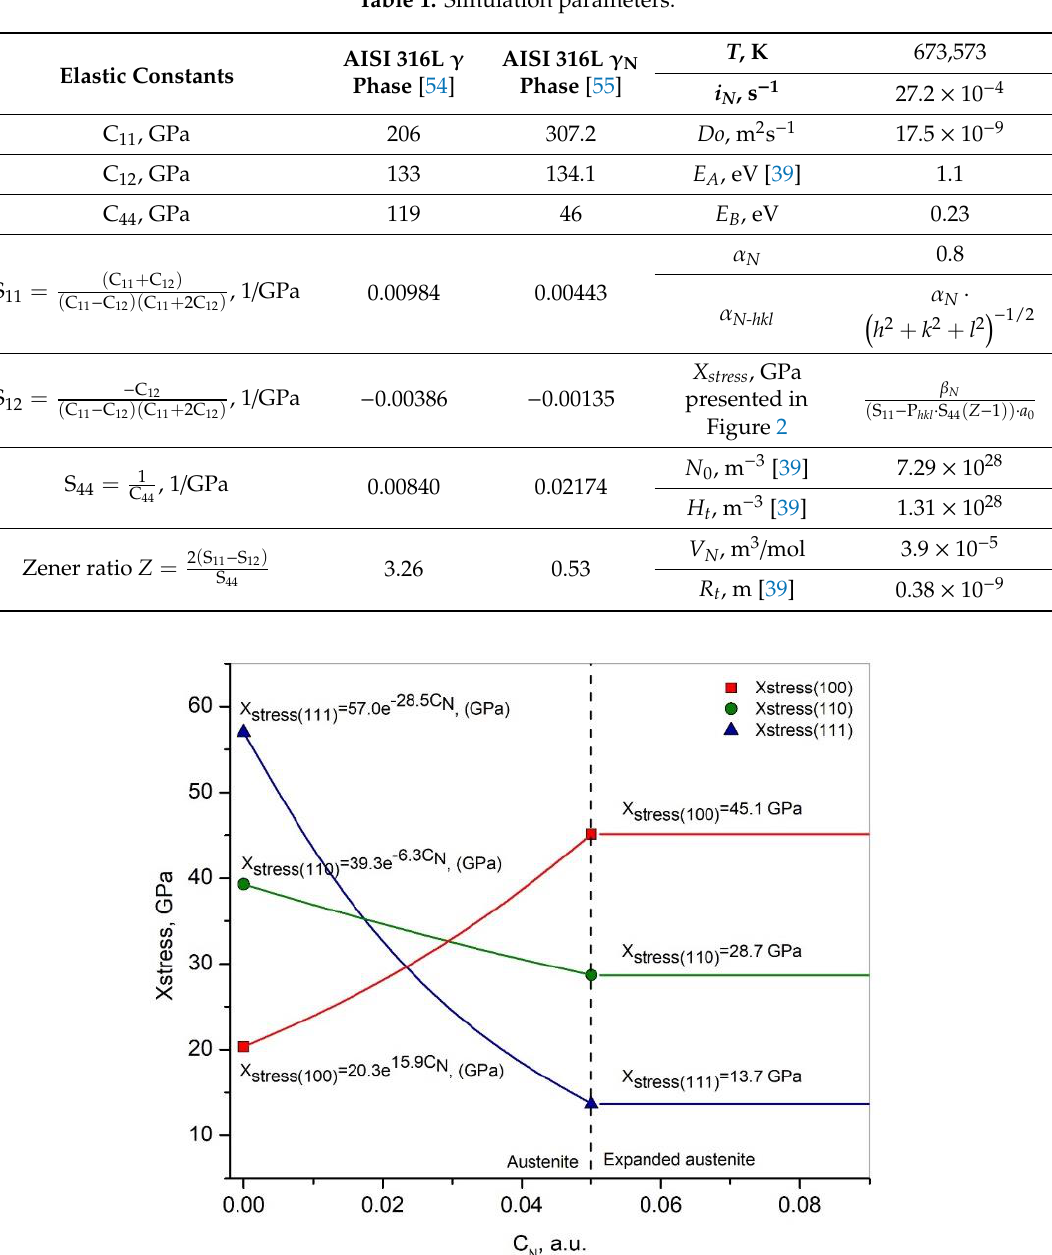
Figure 2. The transition functions and dependences of anisotropic stress factor X stress on nitrogen concentration in the transition period from austenite phase γ to expanded austenite phase γ N for each crystalline orientation.